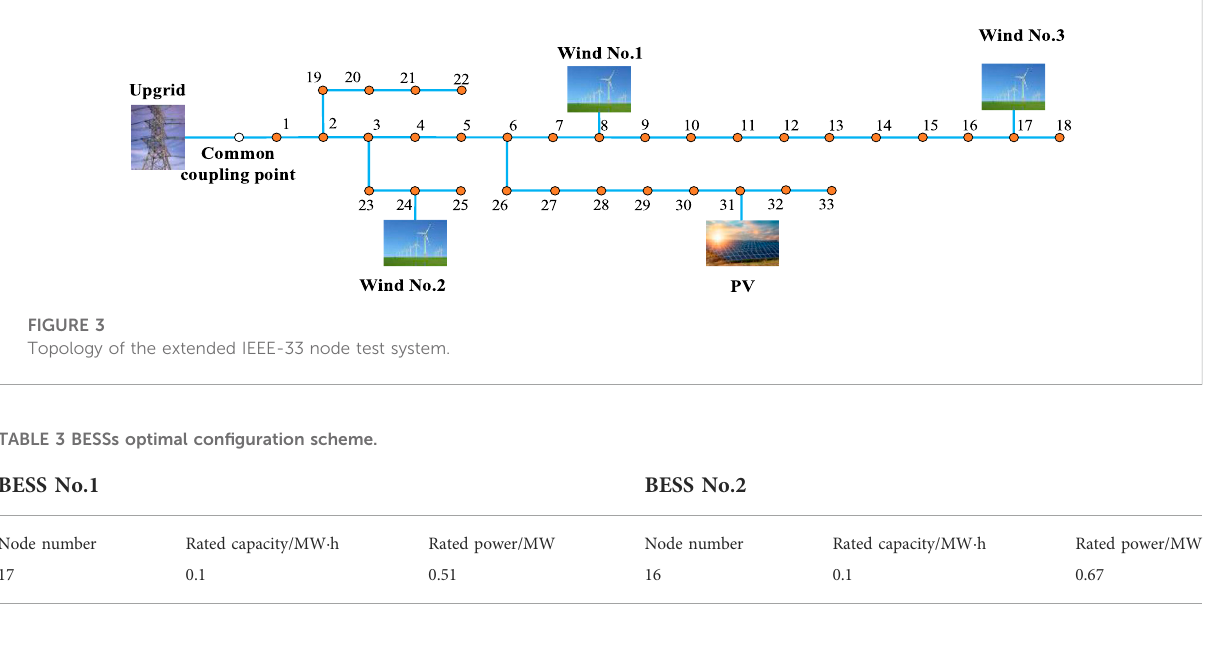
TABLE 4 Comparison before and after BESSs con fi guration. Daily voltage fl